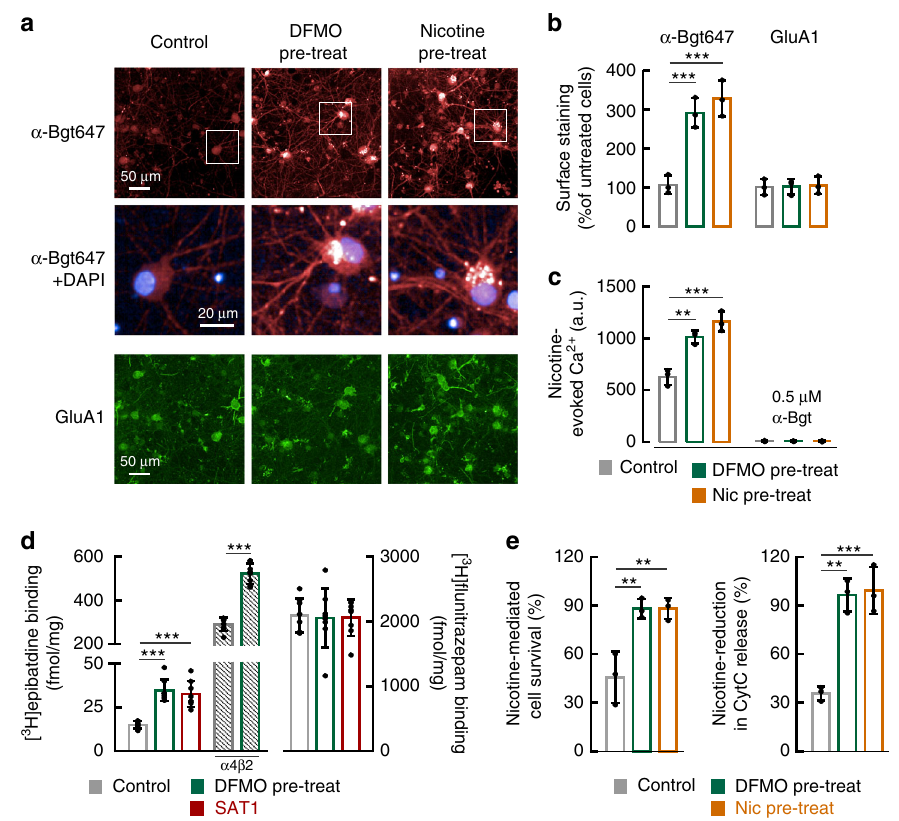
Fig. 6 DFMO enhances both neuronal nAChRs and nicotine-mediated neuroprotection. a Fluorescent labeling of non-permeabilized rat cortical neurons (DIV 20) shows upregulation of endogenous α -Bgt674 labeling in neurons pre-treated for six days with DFMO (5 mM) or nicotine (Nic; 100 μ M) as indicated. Surface-labeling for α 7 used α -Bgt647 (red) and insets (white squares) depict magni fi cations that include DAPI (blue). Double-labeling with α - GluA1 (green) served as control. b Quanti fi cation of surface α -Bgt647 shows increased staining with both DFMO and Nic ( p < 1e − 4 ), but no change was observed in surface GluA1 staining ( p = 0.9). c Summary graph showing nicotine (100 μ M) + PNU-12059615- (10 µ M) evoked Ca 2 + from rat cortical neurons (DIV 13) increases when pre-treated for six days with DFMO ( p = 0.002) or nicotine ( p = 0.0004). Responses were blocked by α -Bgt (0.5 μ